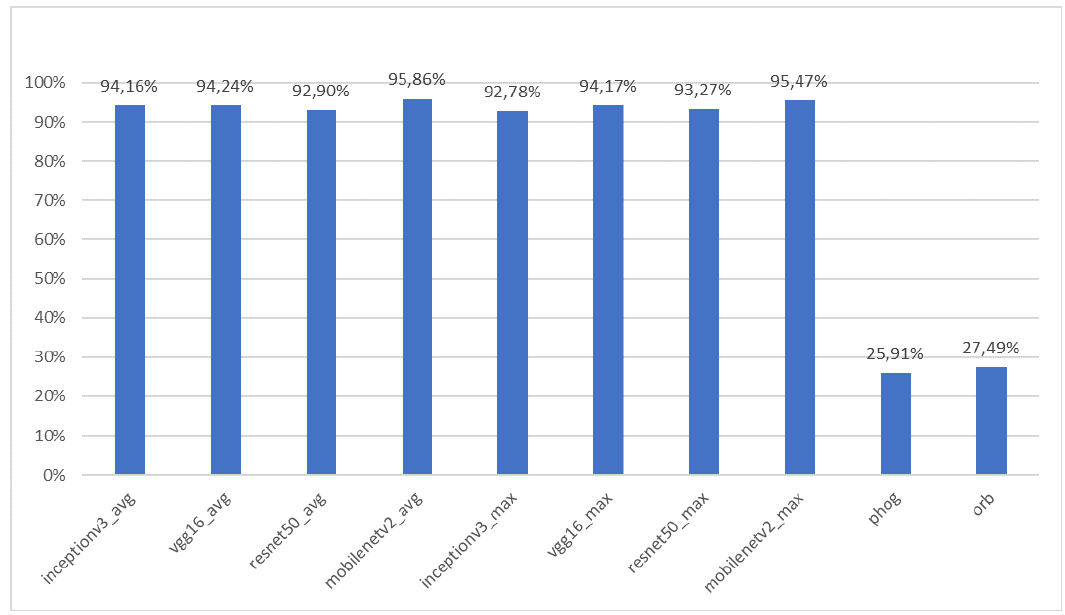
Figure 14. MAP@10 for Image Descriptors.